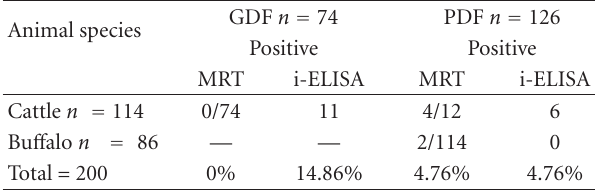
Table 2: Comparison of prevalence of brucellosis in government and privately owned dairy farms in Quetta city, Pakistan. GDF n = Animal species